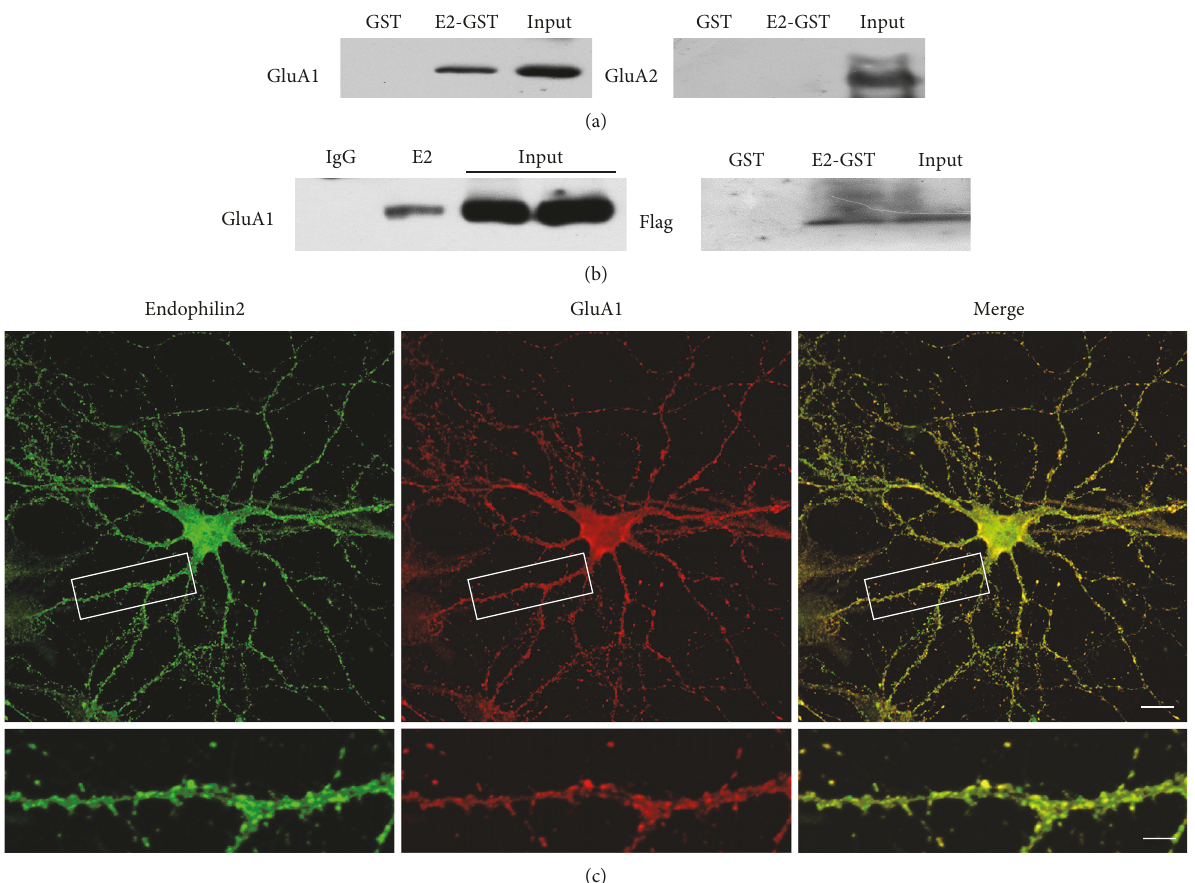
Figure 5: Endophilin2 colocalizes with GluA1. (a) GST-endophilin2 binds to GluA1 not GluA2. GST-tagged endophilin2 fragments were incubated with 1-month-old Sprague Dawley rat brain lysates. Input and bound proteins were analyzed by immunoblotting with antibodies against GluA1 and GluA2. (b) Lysates from 1-month-old Sprague Dawley rat brain were subjected to coimmunoprecipitation with endophilin2 antibody and then subjected to Western blot analysis with GluA1 antibody (left). GST-tagged endophilin2 fragments were incubated with the lysates of HEK293 cells with GluA1-C- fl ag overexpression (right). (c) Immunostaining of DIV14 hippocampal cultured neurons shows endogenous endophilin2 localized with GluA1. Scale bars are 20 μ m and 5 μ m in the magni fi ed dendrite. For pulldown assay, we used rat brain lysates, n = 4 from 4 SD